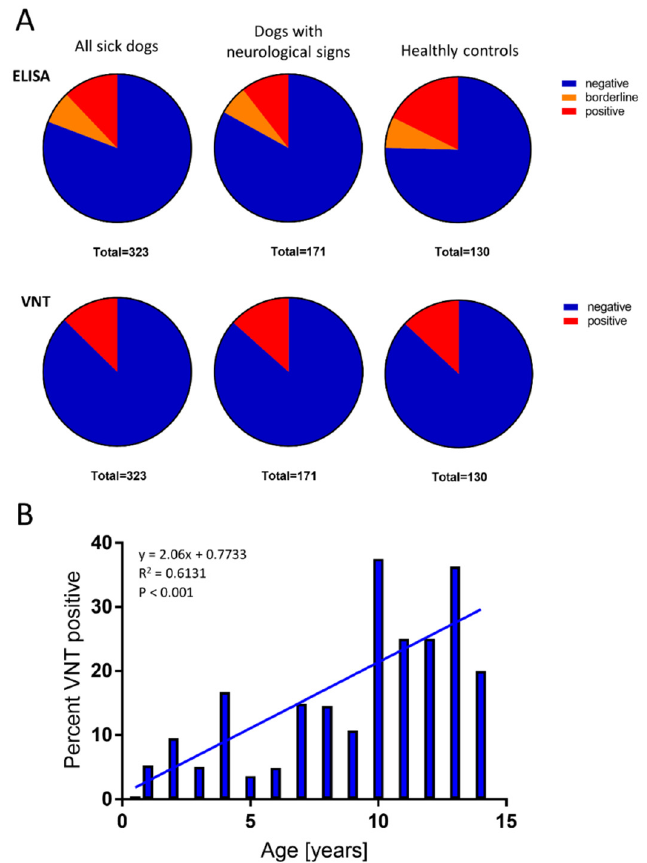
Figure 3. TBEV seroprevalence study in dogs. Serum samples were collected from 453 dogs in the Czech Republic. ( A ) Pie charts show the results of TBEV tests among healthy dogs ( n = 130, right ) and dogs investigated for various health problems (all sick dogs, n = 323, left ); among the latter, 171 had signs of neurological impairment (dogs with neurological signs, middle ). Each pie chart shows the proportion of dogs in each group with TBEV-specific IgG antibodies (ELISA results, upper row ) and virus-neutralising antibodies (VNT results, lower row ). ( B ) Correlation analysis shows the relationship between TBEV seropositivity rates and dog age (correlation curve is shown). Age groups comprised at least 10 dogs each.